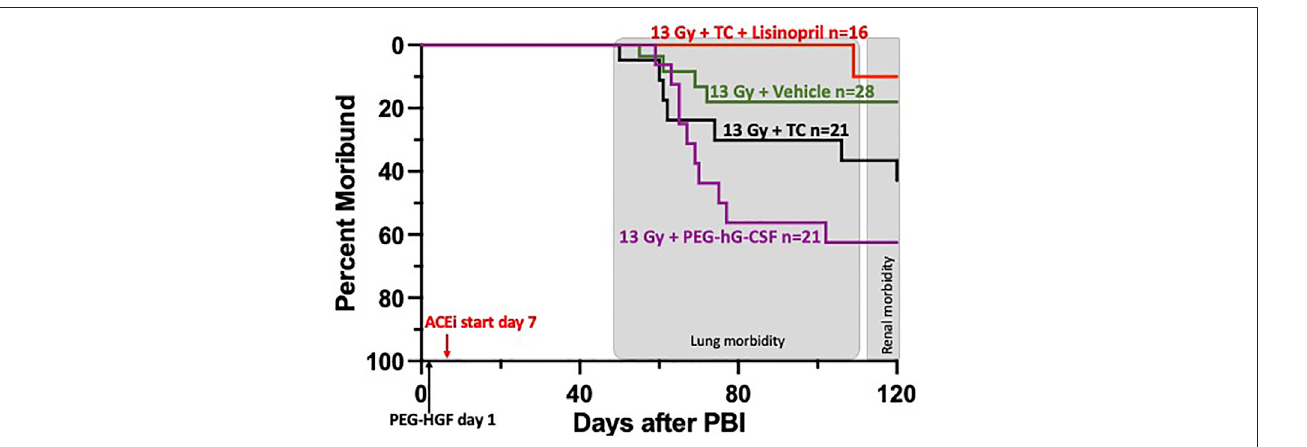
FIGURE 4 | Kaplan-Meier plot representing morbidity from DEARE up to 120 days post 13 Gy partial body irradiation with one hind limb shielded (legout PBI). The triple combination (TC, consisting of PEG-hG-CSF, PEG mGMCSF and PEG hIL-11), vehicle or PEG-hG-CSF (BBT-015) were given subcutaneously 24 h post leg-out PBI (designated by PEG-HGF) and the ACE inhibitor, lisinopril, was started in the drinking water 7 days post irradiation (24 mg m − 2 d − 1 ). All irradiated rats were given supportive care with subcutaneous hydration (40 ml kg − 1 d − 1 ) and enro fl oxacin (10 mg kg − 1 d − 1 ) from days 3 – 7 to 2 – 14, respectively,. There was trend in lower morbidity in irradiated rats that received TC + lisinopril compared to irradiated rats that received PEG-hG-CSF, but this was not signi fi cant ( p 0.07). Shaded (gray) areas represent the timing for the lung and renal injuries.